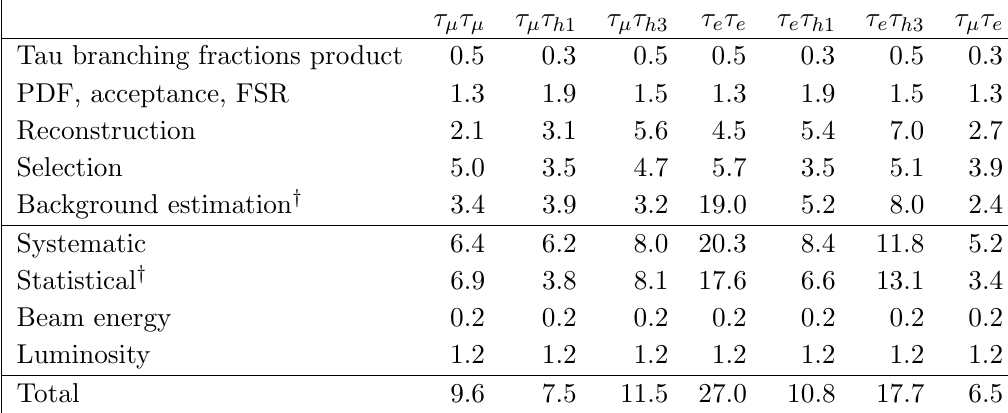
Table 2 . Relative uncertainties of the various contributions a(cid:11)ecting the cross-section measure- ment, given in percent. The uncertainties are correlated between streams, except in rows denoted with y